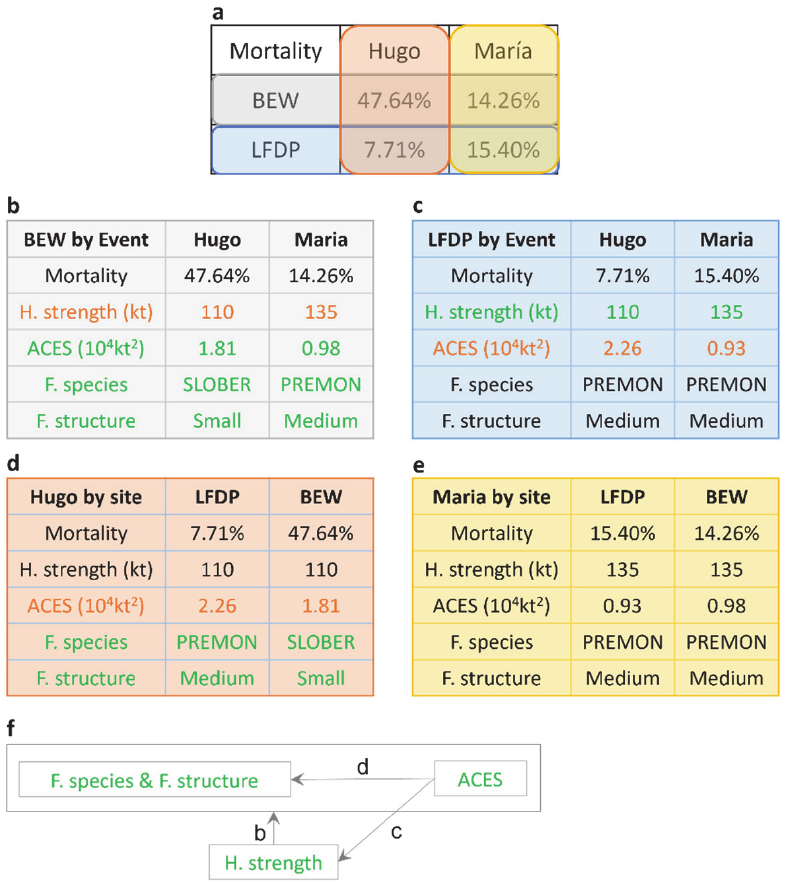
Figure 5. Comparison of mortality and impact factors at Luquillo Forest Dynamics Plot (LFDP) and Bisley Experimental Watersheds (BEW) during hurricanes Hugo and Mar í a. ( a ) The mortality at the two sites during the two hurricane events. The mortality and impact factors at ( b ) BEW during the two events and ( c ) LFDP during the two events. The mortality and impact factors at the two sites during ( d ) hurricane Hugo and ( e ) hurricane Mar í a. ( f ) The relative importance of the impact factors. The mortality at BEW is for stems with DBH ≥ 10 cm, to be consistent with that at LFDP. The mortality between any two events (panels b , c , d ) is significantly different according to z -score test ( p < 0.0001) except that the mortality between LFDP and BEW during Mar í a (panel e ) is not significantly different ( p = 0.5304). In panels ( b – f ), H. strength represents hurricane strength at landfall (in knots), ACES represents accumulated cyclone energy at site (10 4 kt 2 ), F. species represents forest dominant species, and F. structure represents forest dominant DBH size. The mortality, dominant species and DBH size at LFDP are from Uriarte et al. [4], which are also shown in Figure S3. Orange font color indicates that the factor cannot explain mortality while green font color indicates that the factor is consistent with mortality. In panel ( f ), boxing means combining the impact factors, the arrows between boxes indicate relative importance where the direction of the arrow indicates increasing importance. Relative importance is obtained from the corresponding panels ( b – d ) as shown beside the arrows.